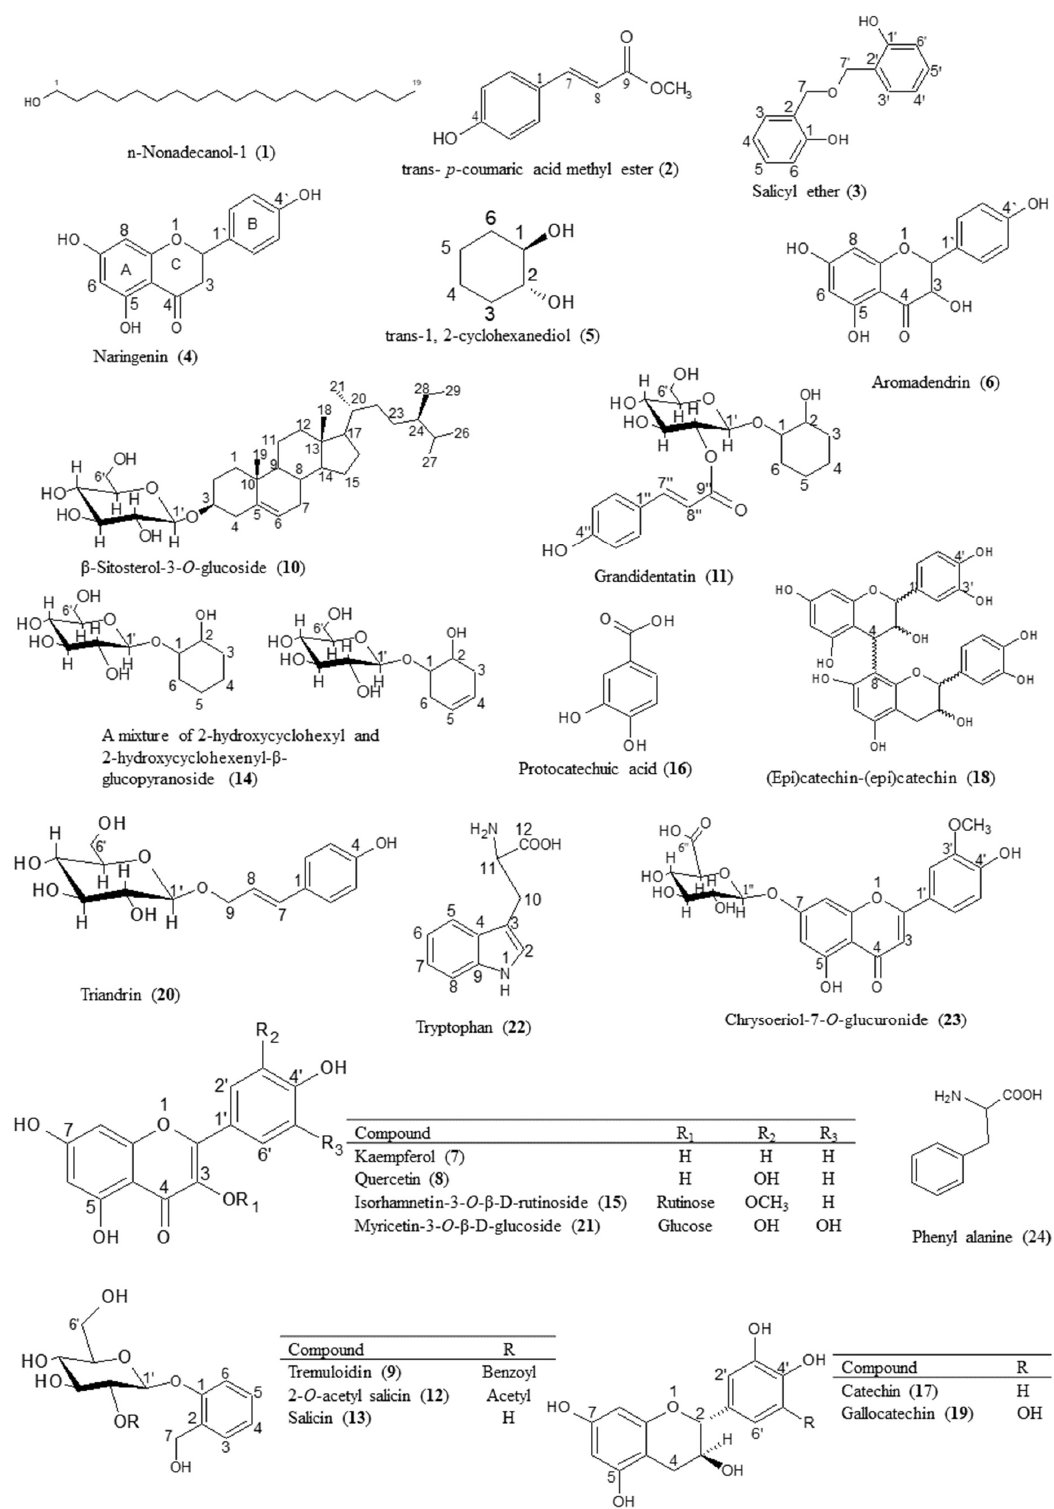
Figure 1. Structures of the isolated natural products from P. alba and S. subserrata .